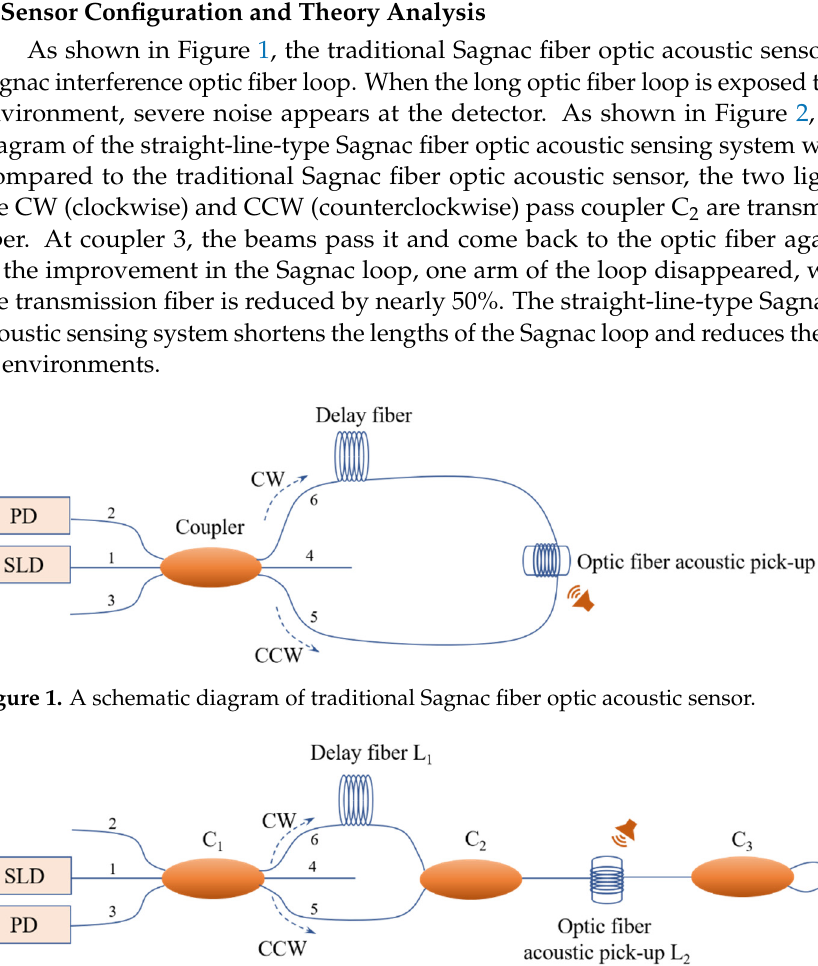
Figure 2. A schematic diagram of straight ‐ line ‐ type Sagnac fiber optic acoustic